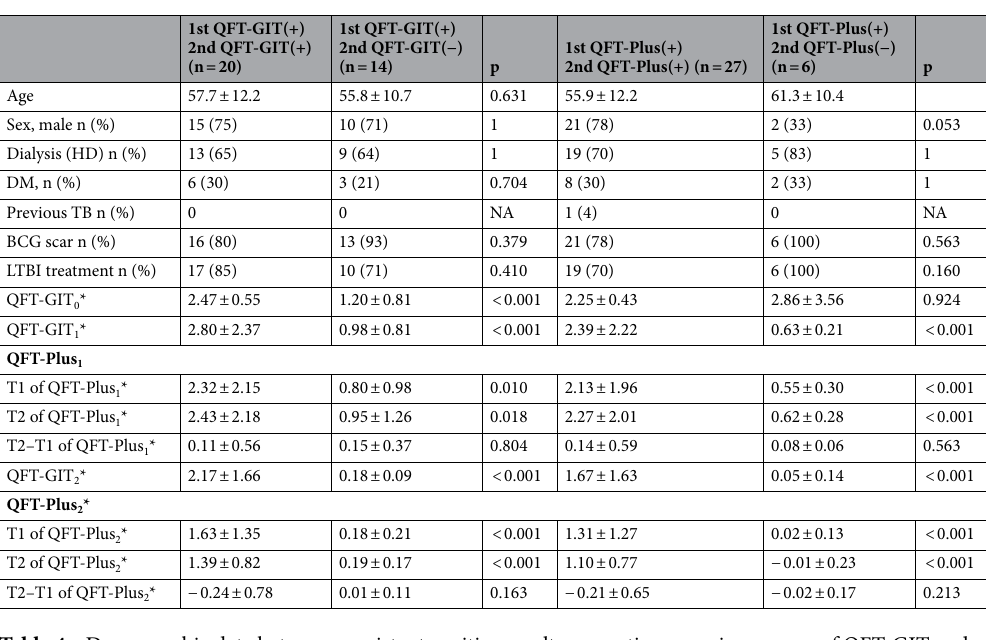
Table 4. Demographic data between persistent positive result or negative reversion groups of QFT-GIT and QFT-Plus. QFT-GIT response: the interferon-gamma level of the TB antigen tube minus the negative control in the QFT-GIT test. The unit is IU/ml. T1/T2 of QFT-Plus: the interferon-gamma level of the TB1 or TB2 tube minus the negative control in the QFT-Plus test. The unit is IU/ml. T2–T1 of QFT-Plus 1 : the level of the T2 tube minus the T1 tube in the QFT-Plus test. The unit is IU/ml. *Subscripts: 0, the baseline test; 1, the 1st follow-up; 2, the 2nd follow-up. BCG, Bacillus Calmette-Guérin vaccine; DM: Diabetes mellitus; F, female; HD, Hemodialysis; LTBI, latent tuberculosis infection; M, male; NA, non-applicable; QFT-GIT: QuantiFERON-TB Gold In-tube; QFT-Plus: QuantiFERON-TB Gold Plus; TB,